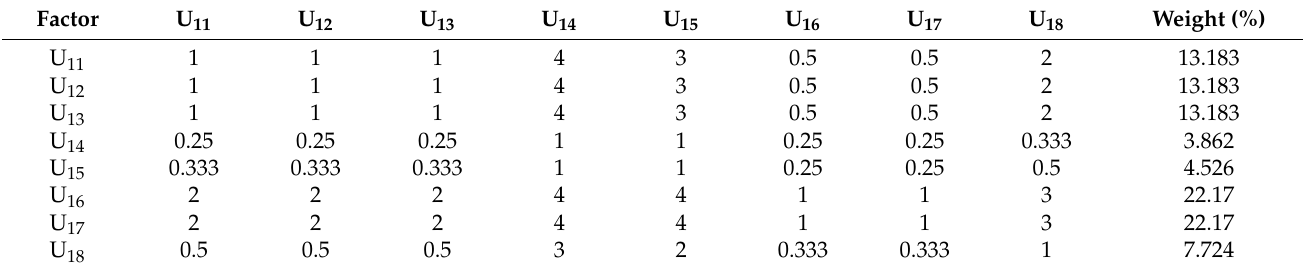
Table 5. Judgment matrix of SZSOJ’s second-level evaluation factors (U 1 ).